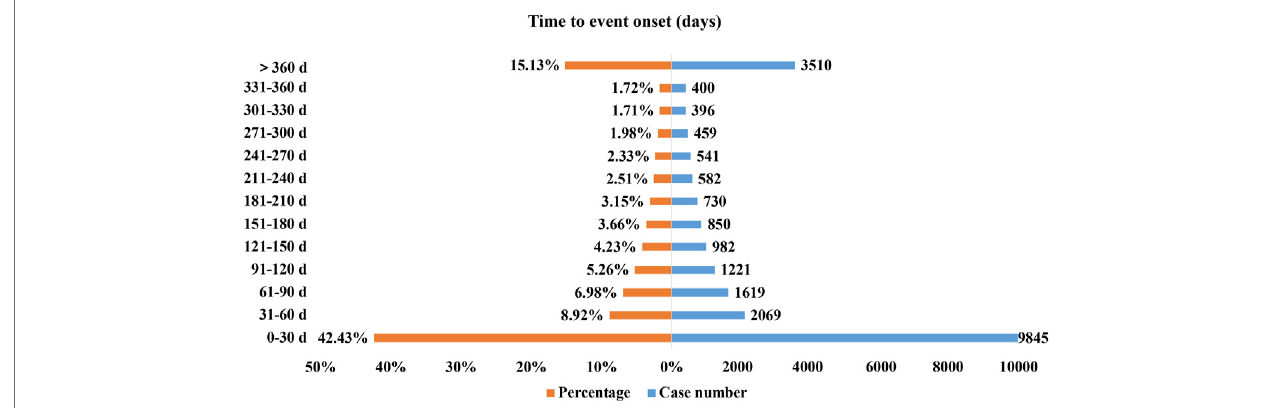
FIGURE 2 | Time to onset of secukinumab-related